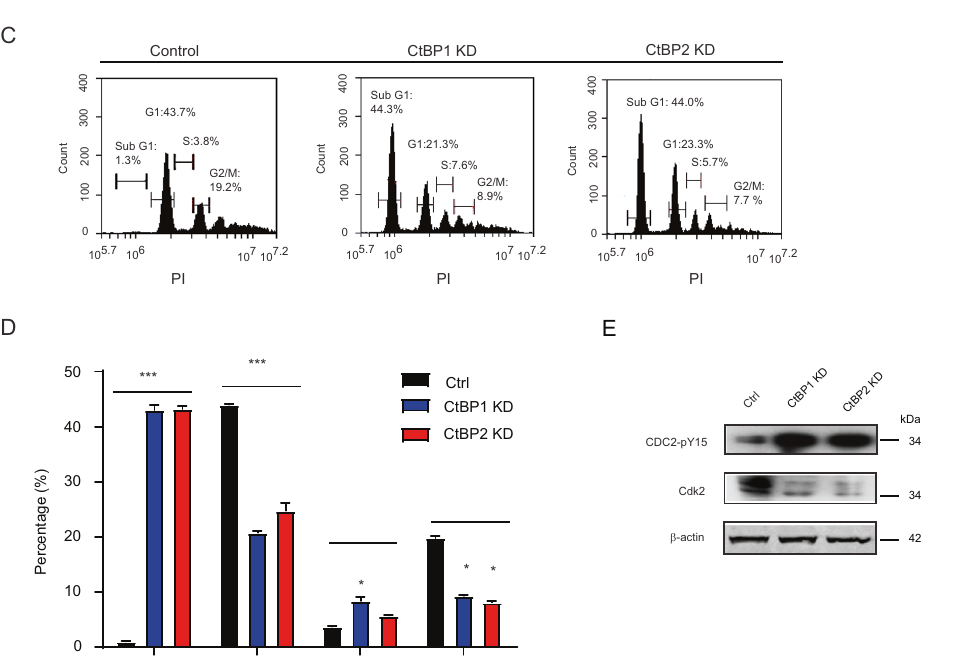
Fig. 2 CtBP1/2 knockdown impacted cell cycle of ovarian cancer cells. The enrichment plot of cell cycle-related genes was identi fi ed by GSEA in CtBP1 KD (left) and CtBP2 KD (right), compared to control cells ( A ). Heat maps signi fi cantly comparing the expression of genes that involved in cell cycle regulation in CtBP1/2 KD and control groups ( B ). The comparison between CtBP1/2 KD and control groups in cell cycle by fl ow cytometry ( C , D ). The cell cycle pro fi le also was created by measuring total DNA content with PI. Data were representing each phase of cell cycle and quantitative analysis the percentage generated by three independent experiments. Western blot analyzed the changed pattern of cell cycle key regulators between CtBP1/2 knockdown and control ( E ). All the data represented the average of triplicates values generated by three independent experiments. * P < 0.05; ** P < 0.001; *** P < mesenchymal transition in colorectal cancer (Fig. 1E). Positively 56 genes (CtBP1 KD vs. CtBP2-KD) (Table S1), 91 genes (CtBP1 KD enriched pathways in CtBP1/2-DKD cells included rapamycin (TOR) vs CtBP1/2 DKD), 108 genes (CtBP2 KD vs CtBP1/2 DKD), and 11 signaling and apoptosis target; negatively enriched pathways genes were overlapped for three groups. Key functional pathways included focal adhesion-PI3K-Akt-mTOR-signaling pathway, tumor were enriched and characterized in CtBP1 KD, CtBP2 KD, and suppression activity of SMARCB1, Wnt signaling pathway, photo- CtBP1/2 DKD cells using GSEA. Three key pathways were dynamic therapy-induced HIF-1 survival signaling, and glycolysis negatively enriched in CtBP1-KD cells, including epithelial to and gluconeogenesis, and metabolic reprogramming in the colon mesenchymal transition in colorectal cancer, MAPK signaling cancer (Fig. 1E). Cell cycle and focal adhesion-PI3K-Akt-mTOR pathway, and cell cycle, while focal adhesion-PI3K-Akt-mTOR- signaling pathways were common enriched pathways between signaling and integrin-mediated cell adhesion were positively CtBP1/2-KD cells. Overexpression of CtBP1/2 was thought to play enriched (Fig. 1D). Positively enriched pathways in CtBP2-KD cells regulatory roles in the cell cycle and adhesion of serous ovarian included G1 to S cell cycle control, MAPK signaling pathway, cell cancer cells. The apoptosis pathway, in particular, had been cycle, DDR, and focal adhesion-PI3K-Akt-mTOR-signaling pathway; highlighted in the enriched functional pathways of CtBP1/2-DKD negatively enriched pathways included TGF-beta signaling and CtBP2-KD cells. pathway, ErbB signaling pathway, apoptosis, and epithelial to